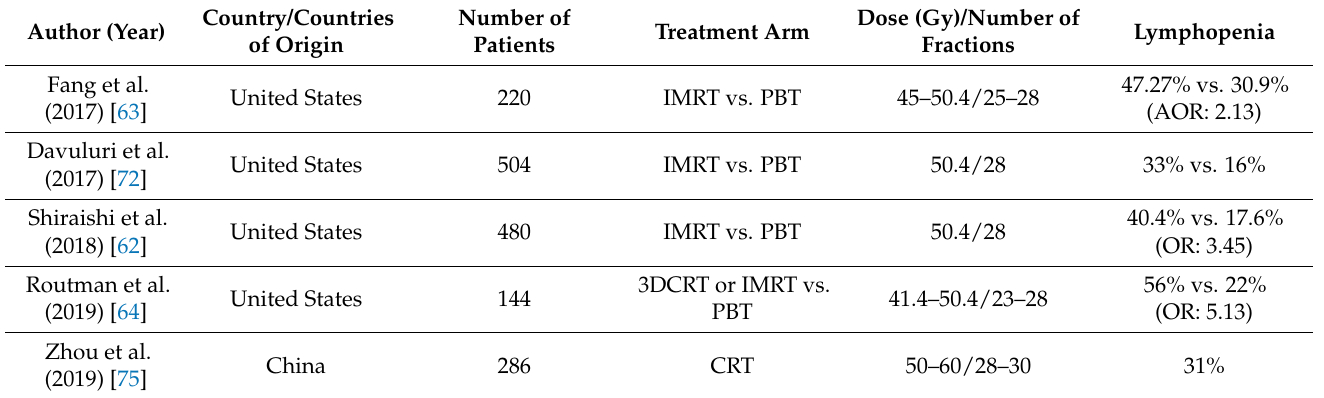
Table 3. Selected studies comparing development of treatment related lymphopenia (TRL) with photon-based therapy vs. PBT for esophageal cancer